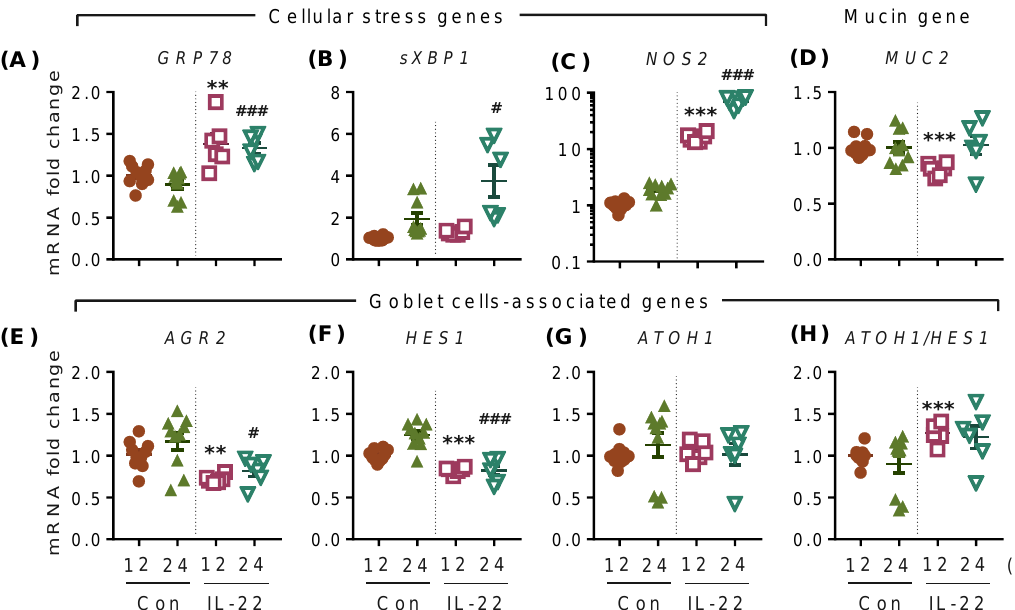
Figure 5. IL-22-mediated transcriptional changes in intestinal LS174T cells. Cells were treated with IL-22 (50 ng / mL) for 12 and 24 h and harvested to collect RNA. Then, qRT-PCR was performed to check the expression of ER stress markers ( A ) GRP78 and ( B ) sXBP1, ( C ) oxidative stress marker NOS2, ( D ) mucin MUC2, goblet cell-associated factors ( E ) AGR2, ( F ) HES1, ( G ) ATOH1, and ( h ) the ATOH1 / HES1 ratio. Data are presented as mean ± SEM with individual cultures ( n = 6–9 from 2–3 independent experiments). ** p < 0.01; *** p < 0.001 compared with 12 h control and ### p < 0.001 compared with 24 h control (nonparametric Man-Whitney t -test).